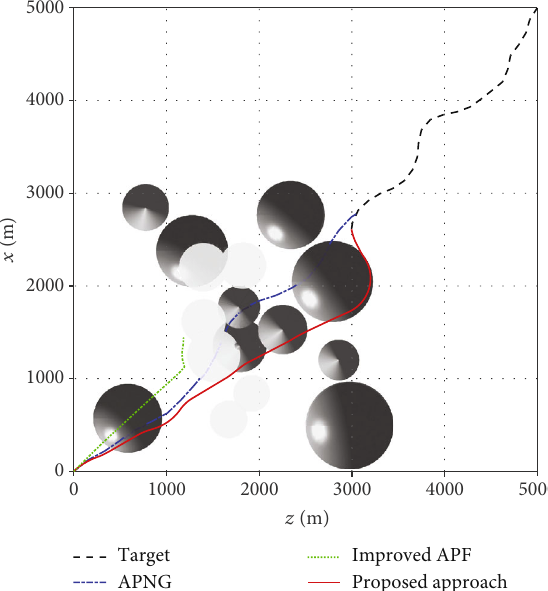
Figure 28: Flight trajectory projections of interceptor and target in case 6.